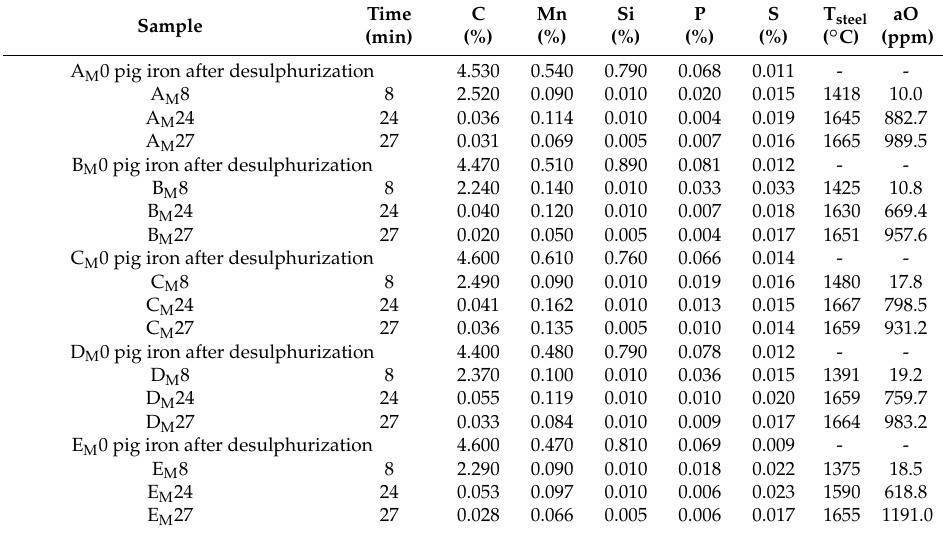
Table 3. Chemical composition of metal samples, temperature and activity of oxygen in the metal.